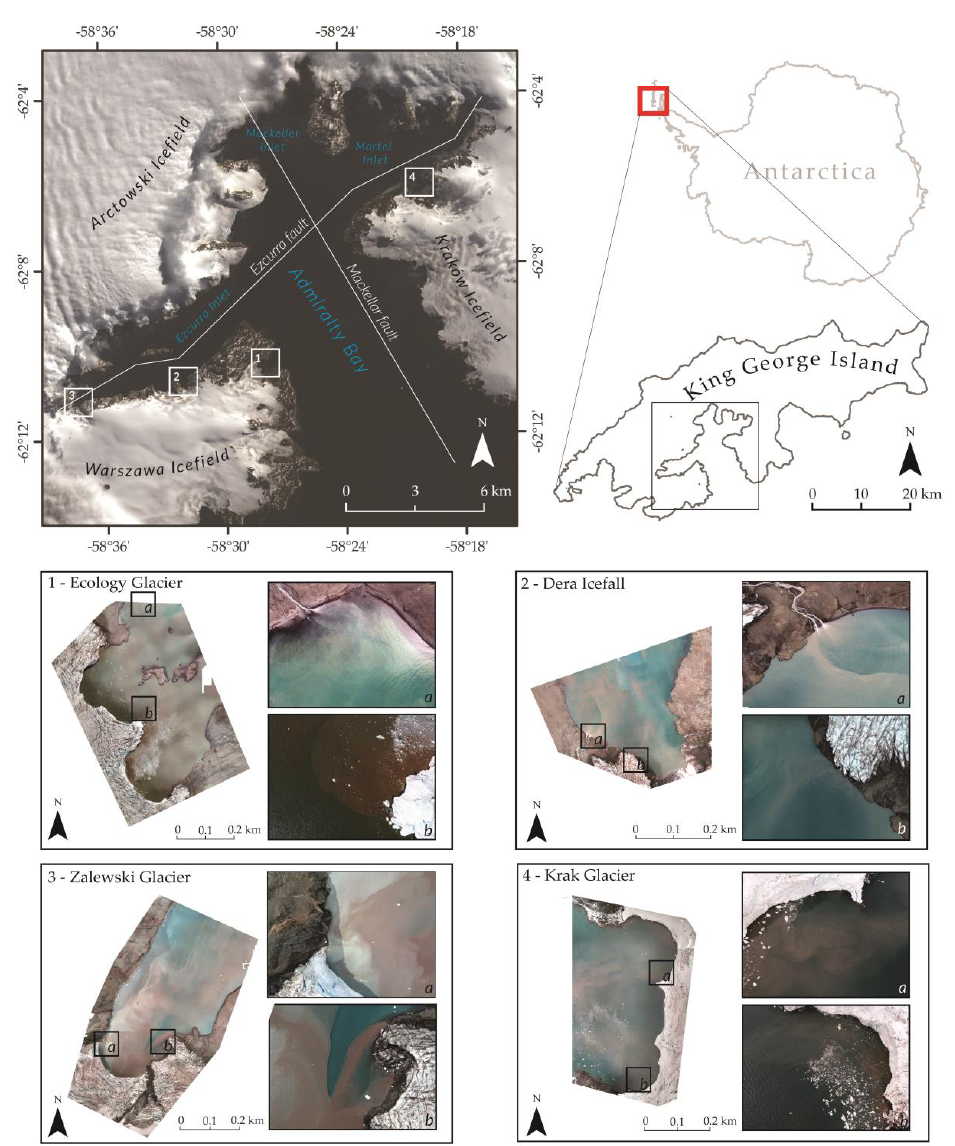
Figure 2. Satellite images (Landsat 8, acquired on 10 March 2018) showing the locations of the selected glaciers (white frames): 1—Ecology Glacier, 2—Dera Icefall, 3—Zalewski Glacier, 4—Krak Glacier. Black frames labelled a and b mark the positions of subglacial discharges and surface runoffs to particular glacier-front coves (images produced by a Zenmuse X5 camera from the Inspire 2 quadcopter drone).